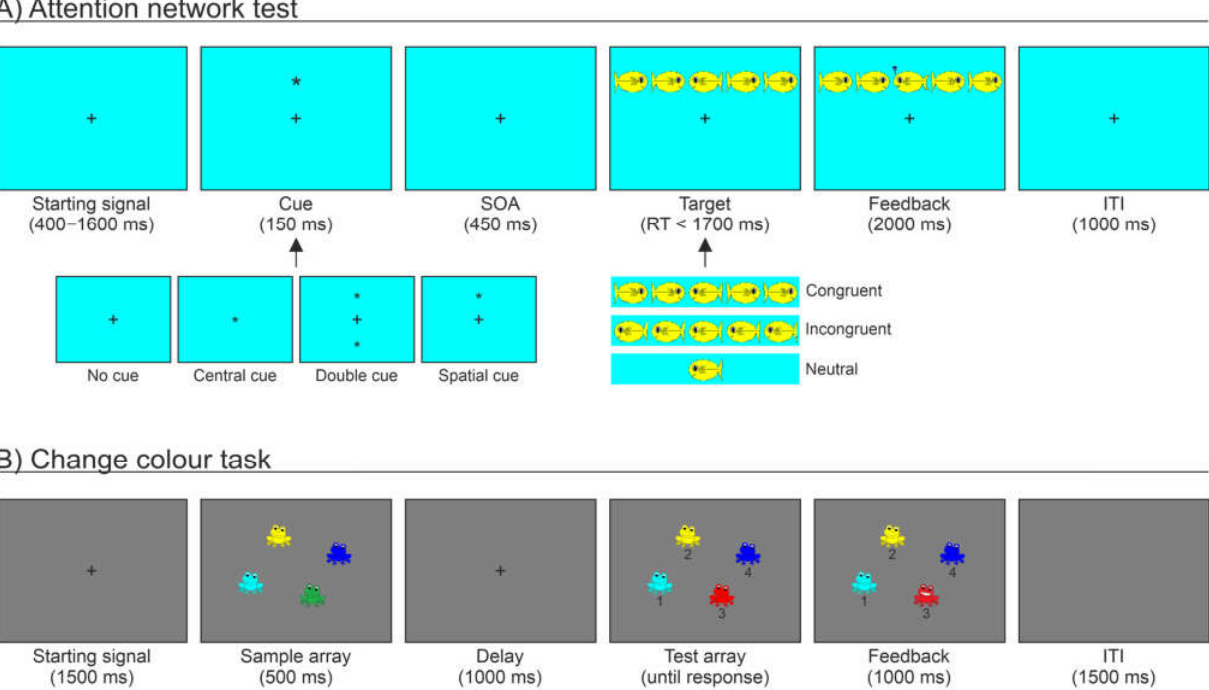
Figure 1. Experimental protocol consisting of the Attention Network Test, ANT ( A ), and Change Colour Task, CCT ( B ). ( A ) Schematic diagram showing the sequence of events during one ANT example trial (adapted with permission from Rueda et al. [22]. Copyright © 2022 Elsevier Ltd.).